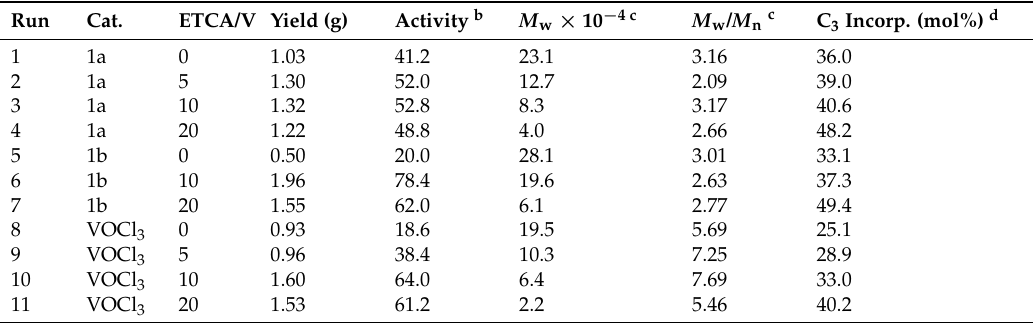
Table 1. Ethylene/propylene copolymerization with V complex/Et 3 Al 2 Cl 3 a